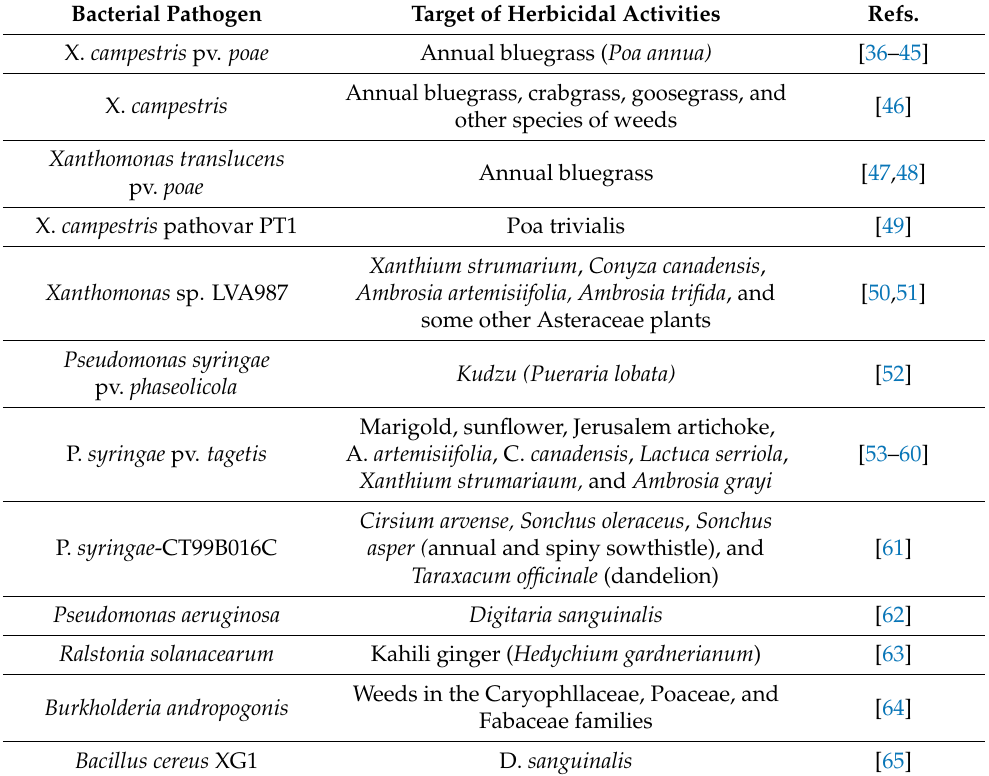
Table 1. Bacterial pathogens of weeds with herbicidal